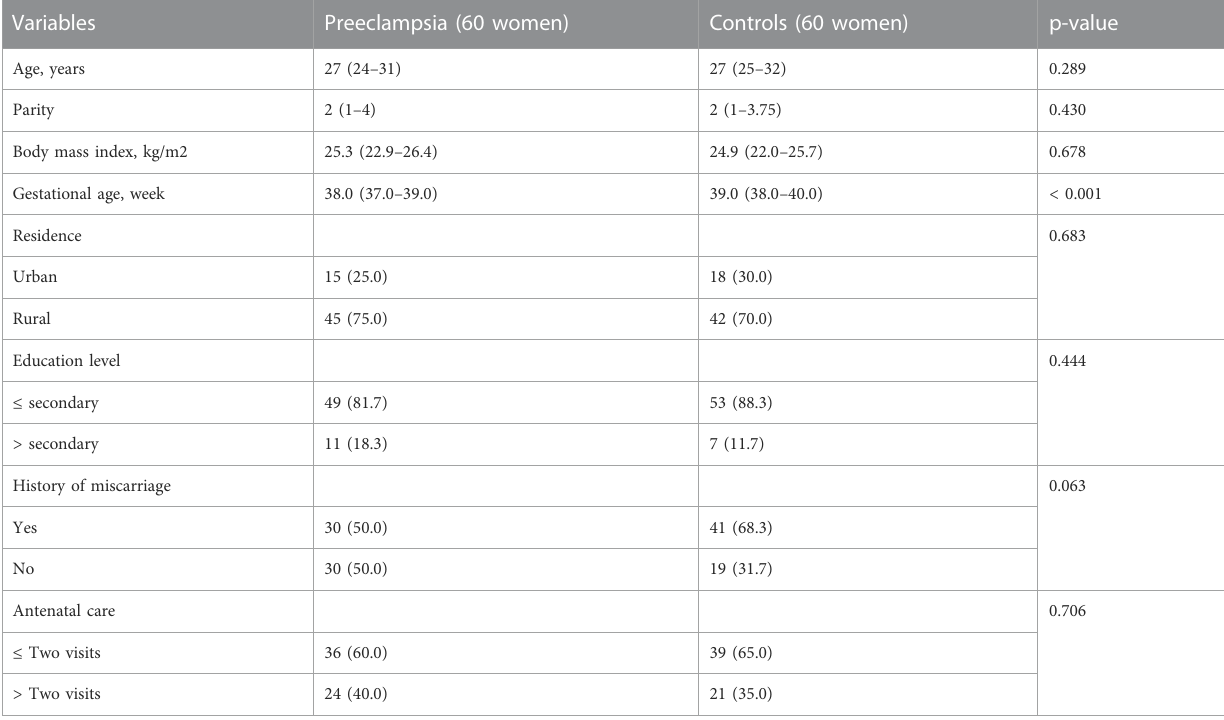
TABLE 1 Comparing frequency (proportions) or median (interquartile range) of the sociodemographic and clinical variables between women with preeclampsia and controls in Khartoum Sudan, 2020. Variables